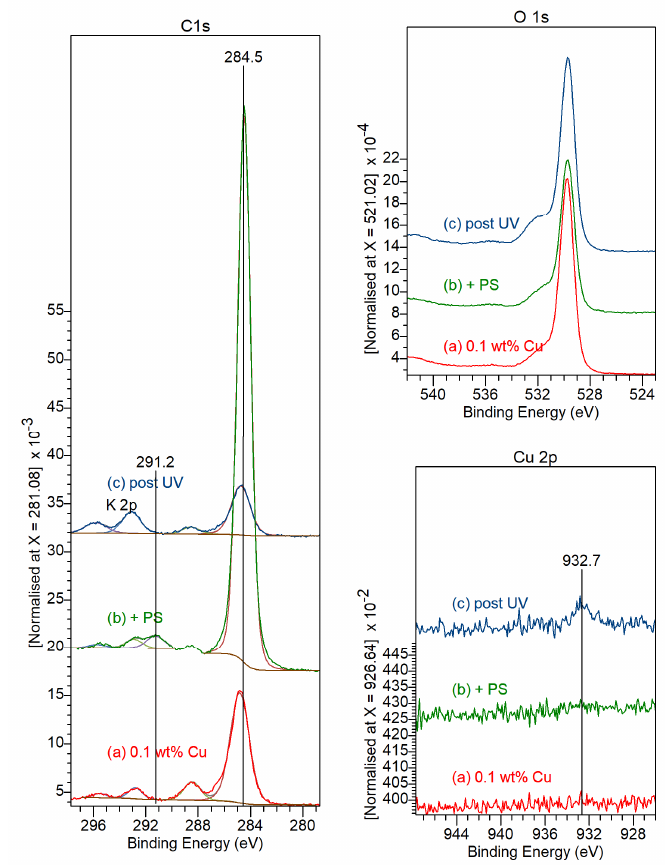
Figure 4. Photoelectron spectra of the 0.1 wt% Cu-doped TiO 2 catalysts. ( a ) Clean coating deposited at 500 rpm; ( b ) Coating deposited at 5000 rpm with polystyrene deposited on top. ( c ) Coating deposited at 5000 rpm with polystyrene after 72 h photocatalysis in air.